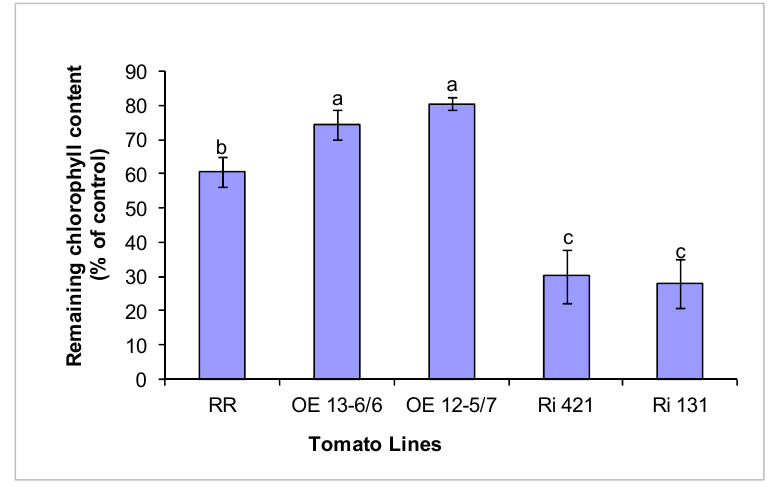
Figure 1. Effect of sulfite application on wild type and SO modified tomato lines. Leaf discs of wild type (RR), SO OE lines (OE 13-6/6, OE 12-5/7) and SO Ri lines (Ri 421, Ri 131) were subjected to ( A ) 0 mM and ( B ) 7 mM Na 2 SO 3 and photographed 24 h after starting the treatment.